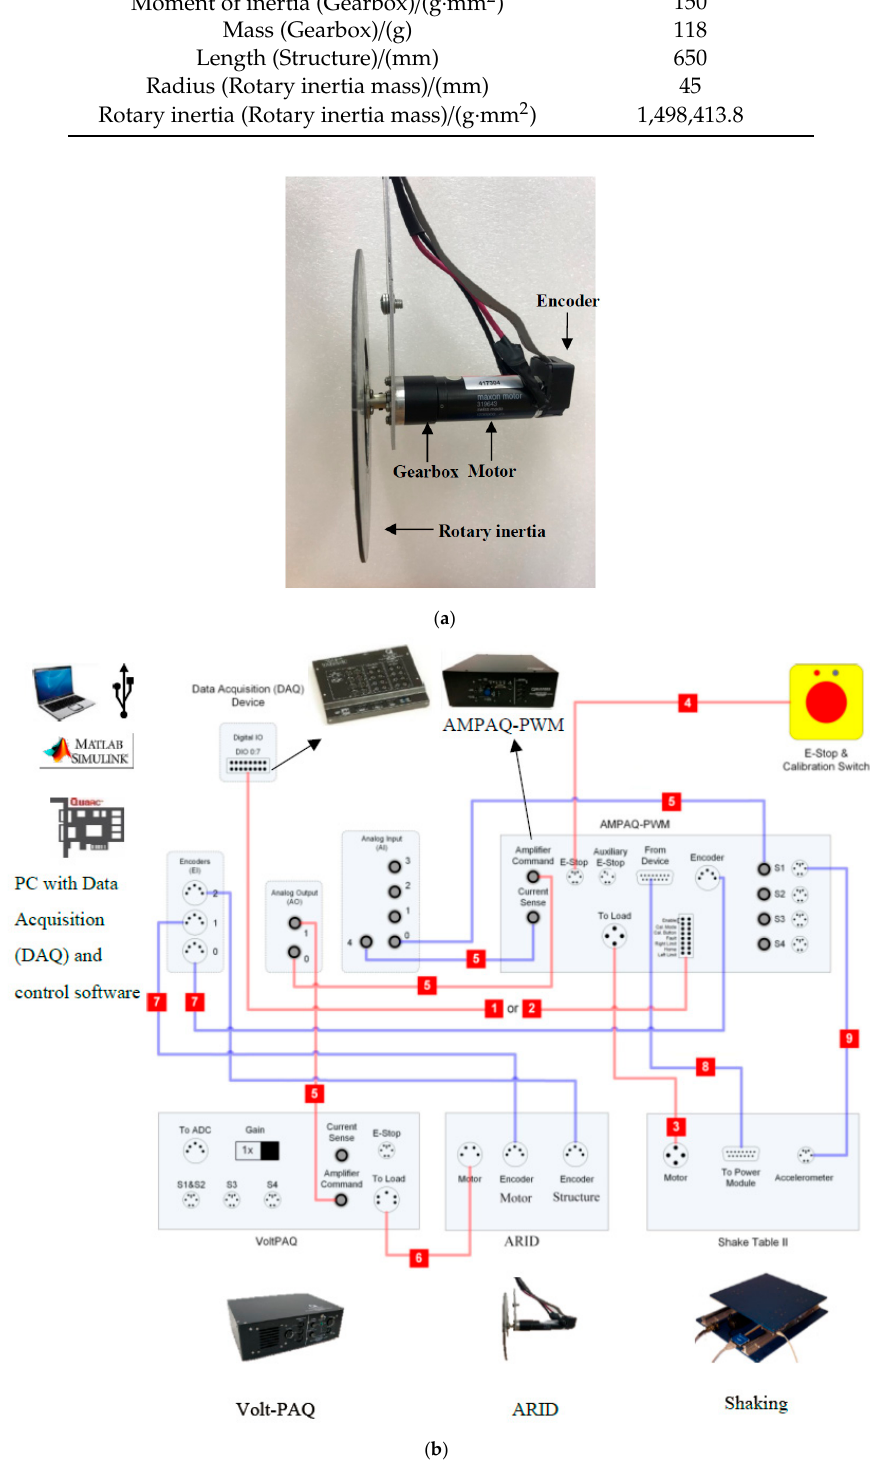
Figure 5. Photo of the ARID experiment system: ( a ) Photo of the ARID actuator; ( b ) schematic of the experimental system.